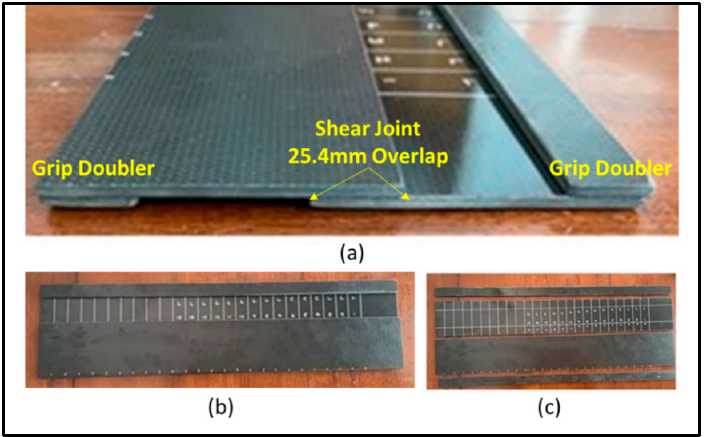
Figure 7. Adherend layout before adhesive cure: ( a ) side view, ( b ) plan view, ( c ) part view. The adherends were vacuum-bagged and secondarily bonded together with two layers of FM300-2K film adhesive at 121 ◦ C for 90 min [27]. Figure 8 shows the bonded coupons